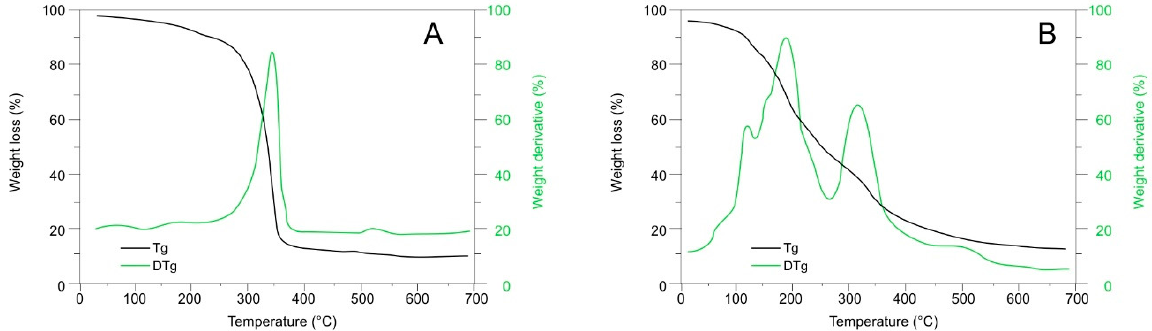
Figure 8. Thermogravimetric analysis of nanocellulose and H. macrocarpa powder ( A ) and H. macrocarpa extract ( B ).